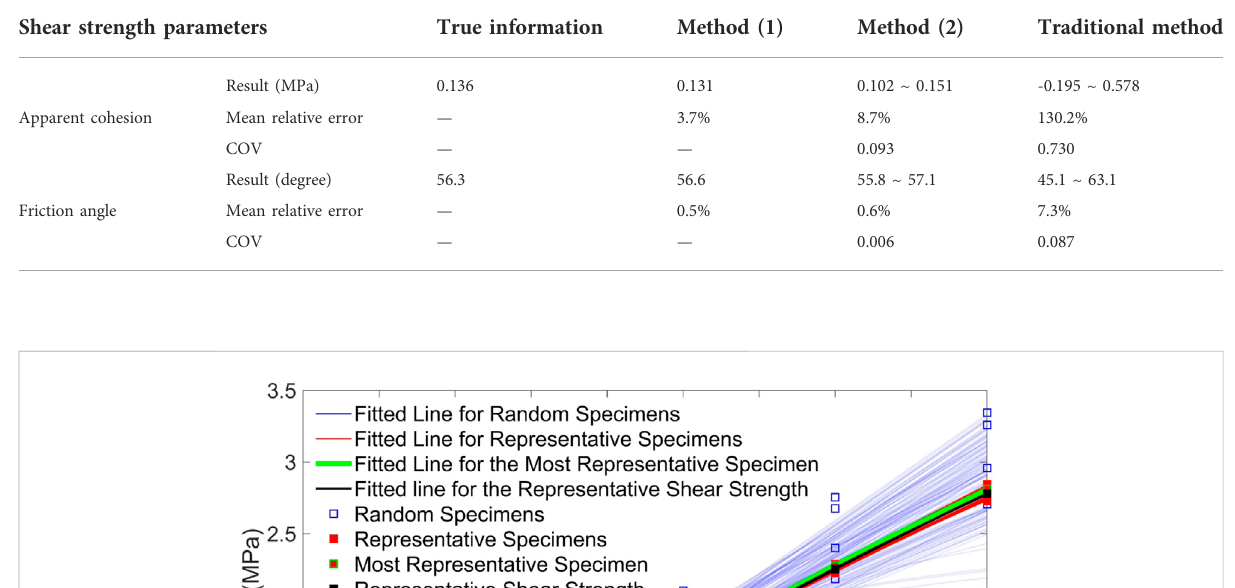
TABLE 2 Shear strength parameters based on different methods.